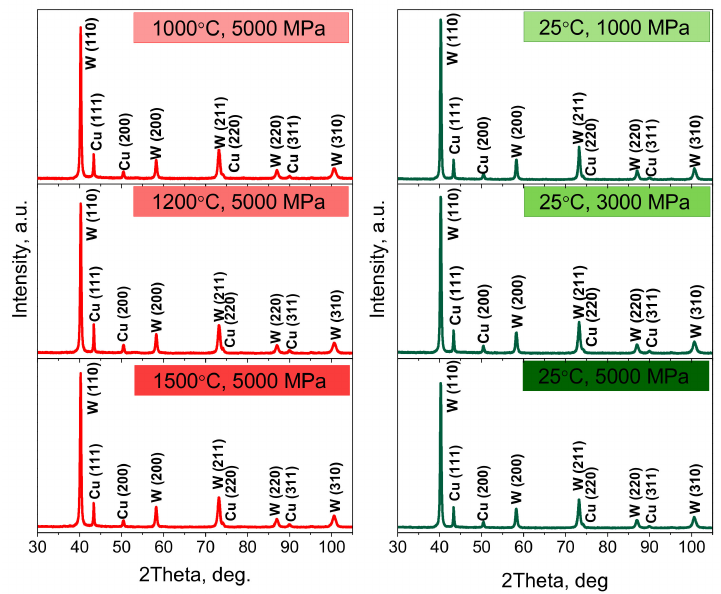
Figure 7. XRD patterns of W–Cu composite samples obtained in different sintering